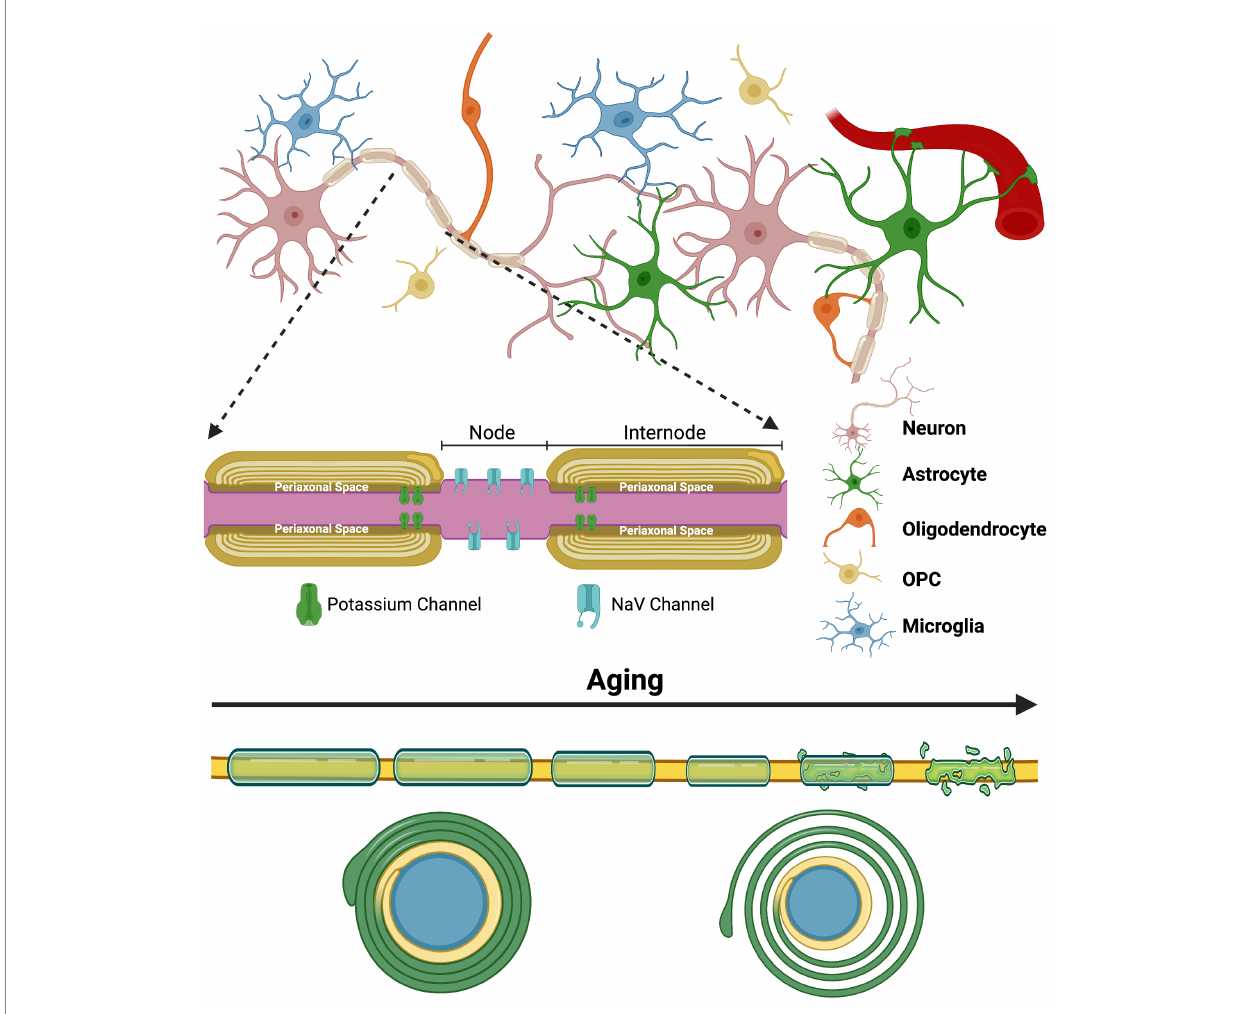
FIGURE 1 The complex glial interactions that promote proper myelination and the general impact aging has on the myelin sheath | The process of myelination is extremely complex and is constantly evolving to our experiences and various environmental insults throughout the lifespan. Myelination is highly adaptive and is fine-tuned to these experiences through neuronal activity. Proper functioning of the myelinating glial cells of the CNS— oligodendrocytes—and their precursor cells—oligodendrocyte progenitor cells (OPCs)—is essential, but the process also heavily relies on astrocytes and microglia. The top half of this figure depicts the complex arrangement that exists between the various glial cells and neurons that all contribute to proper myelination and circuit formation. The inset depicts the internodes of a myelinated axon and the nodes of Ranvier that they create. Lastly, the bottom of this figure shows the general alterations and ultimate degeneration that many myelinated axons face with increasing age. Typically, myelin sheaths become thinner, shorter and less compact (shown by the axon cross-section at the bottom) with age, although many other abnormalities also occur. These abnormalities also contribute to the disorganization of ion channels at the paranode and at the nodes of Ranvier. Created with BioRender.